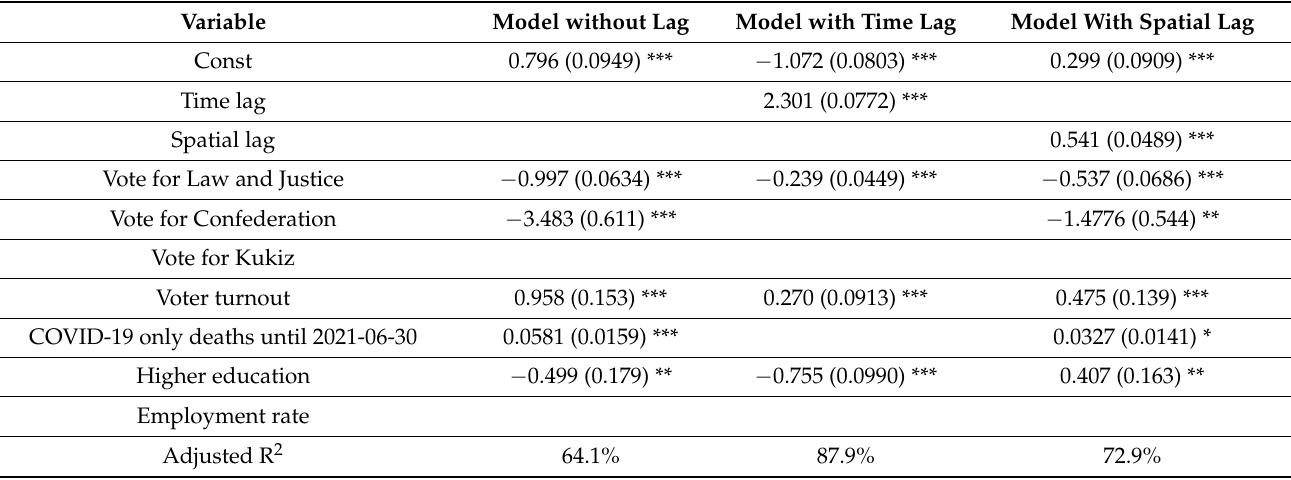
Table 4. Percentage of remaining population in age group 70 and over that were vaccinated against COVID-19 between 30 June 2021 and 31 January